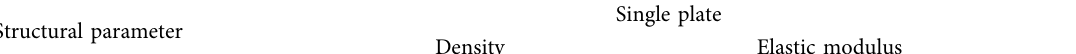
Figure 5: Mapping strategy. Table 1: Discretization of structural parameters.